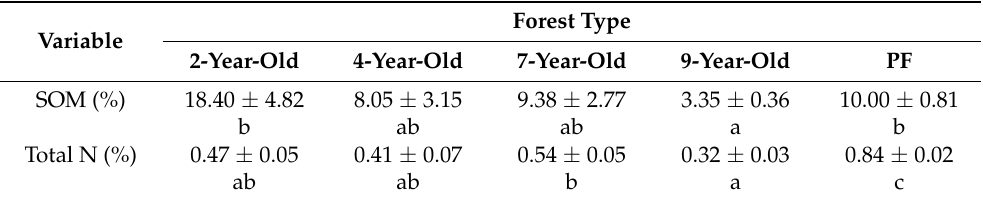
Table 1. Mean ( ± standard error) soil organic matter (SOM) and total nitrogen (N) in fallow forests between two- and nine-years-old, and primary forest (PF) in coastal areas of north Manokwari, West Papua, Indonesia. Different lowercase letters show the differences according to Tukey’s tests with p <